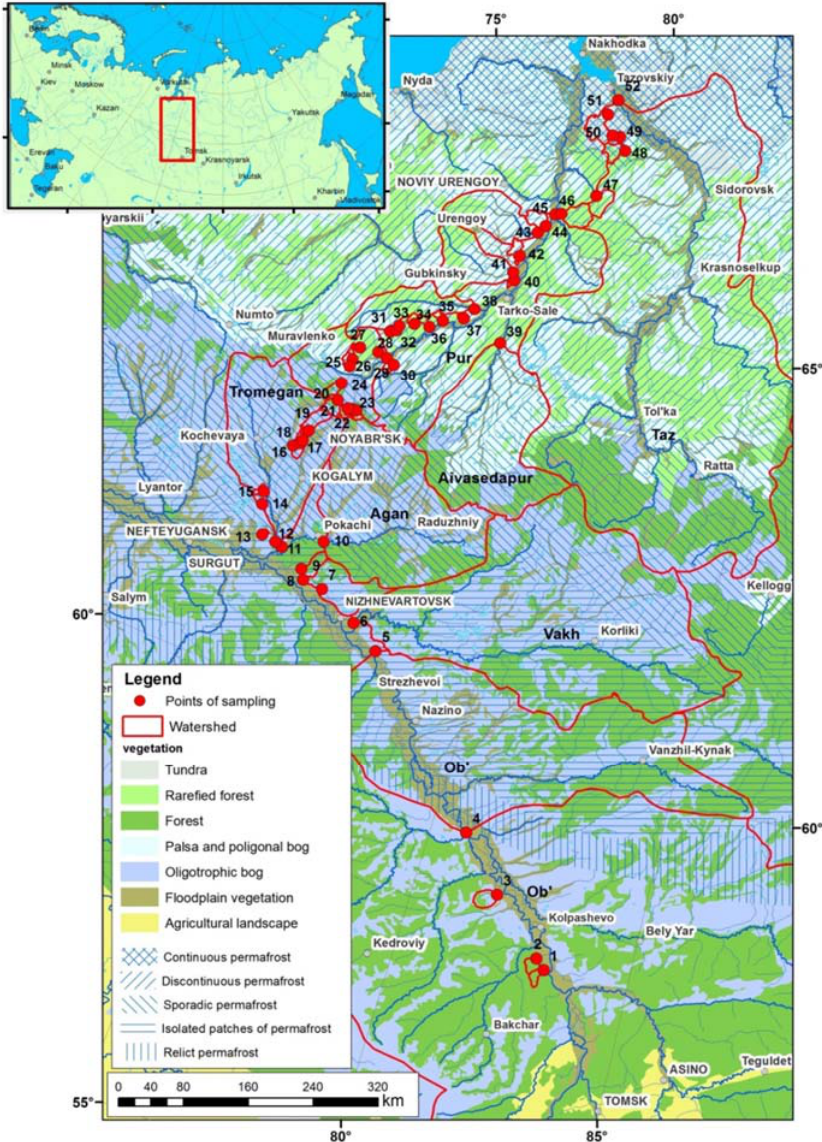
Figure 1. Sampling sites and physico-geographical context of WSL territory investigated in this work.